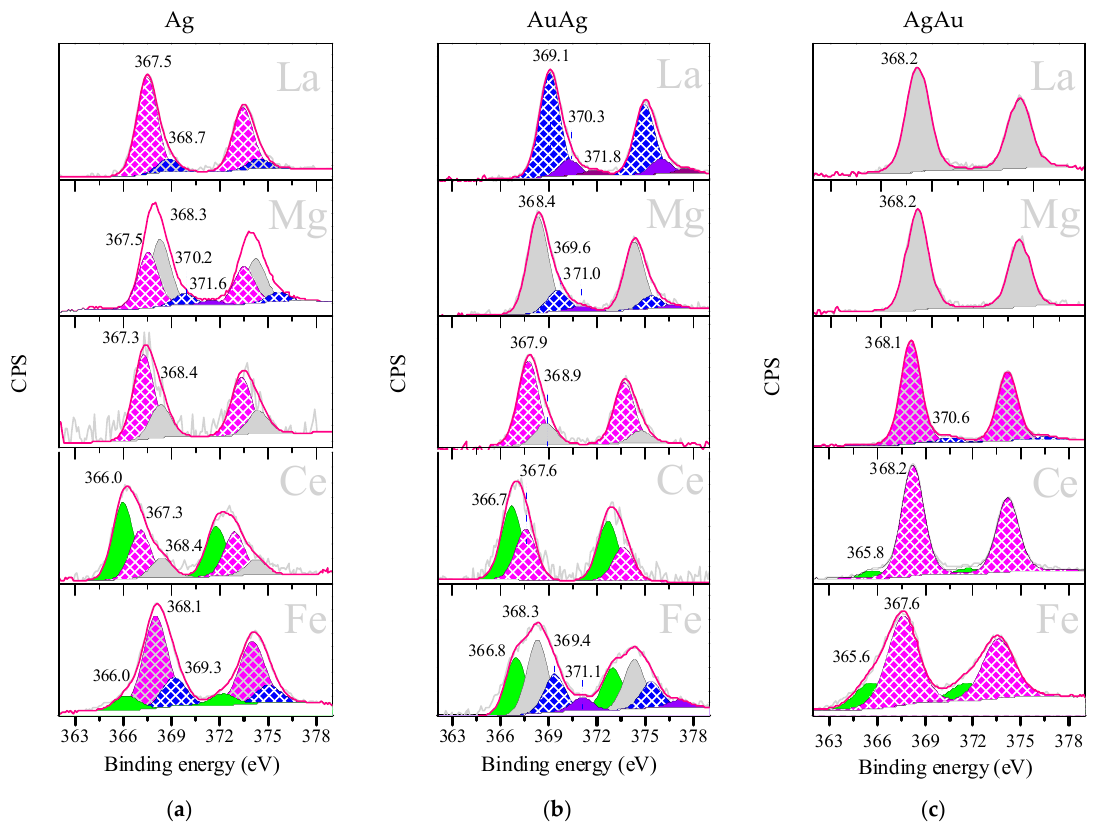
Figure 5. Ag 3d 5/2 XPS for Ag ( a ), AuAg ( b ) and AgAu ( c ) catalysts supported on M/TiO 2 , where M is La, Mg, Ce or Fe. Samples were studied after reduction in H 2 at 300 °C for 1 h. Some previously reported XPS results of Ag ‐ based samples are shown in ( a ) [63]. Table 2. BE of different silver electronic states (eV) and their relative content (%), indicated in parenthesis. Data for Ag/M/TiO 2 were adapted from [63].